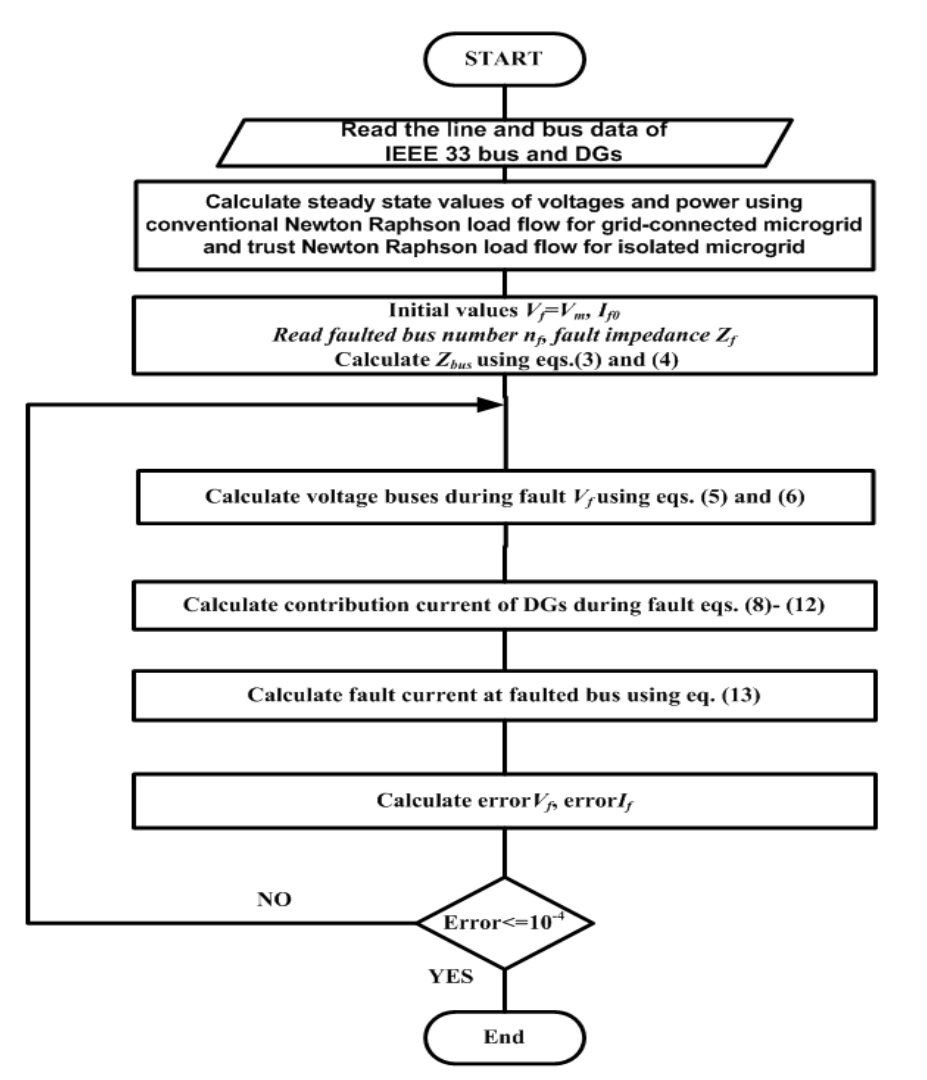
Figure 3. Flow chart of the proposed technique .